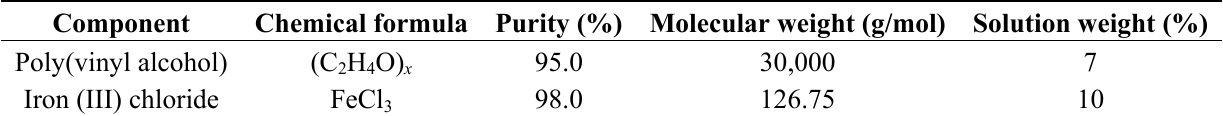
Table 1. Components of photopolymer